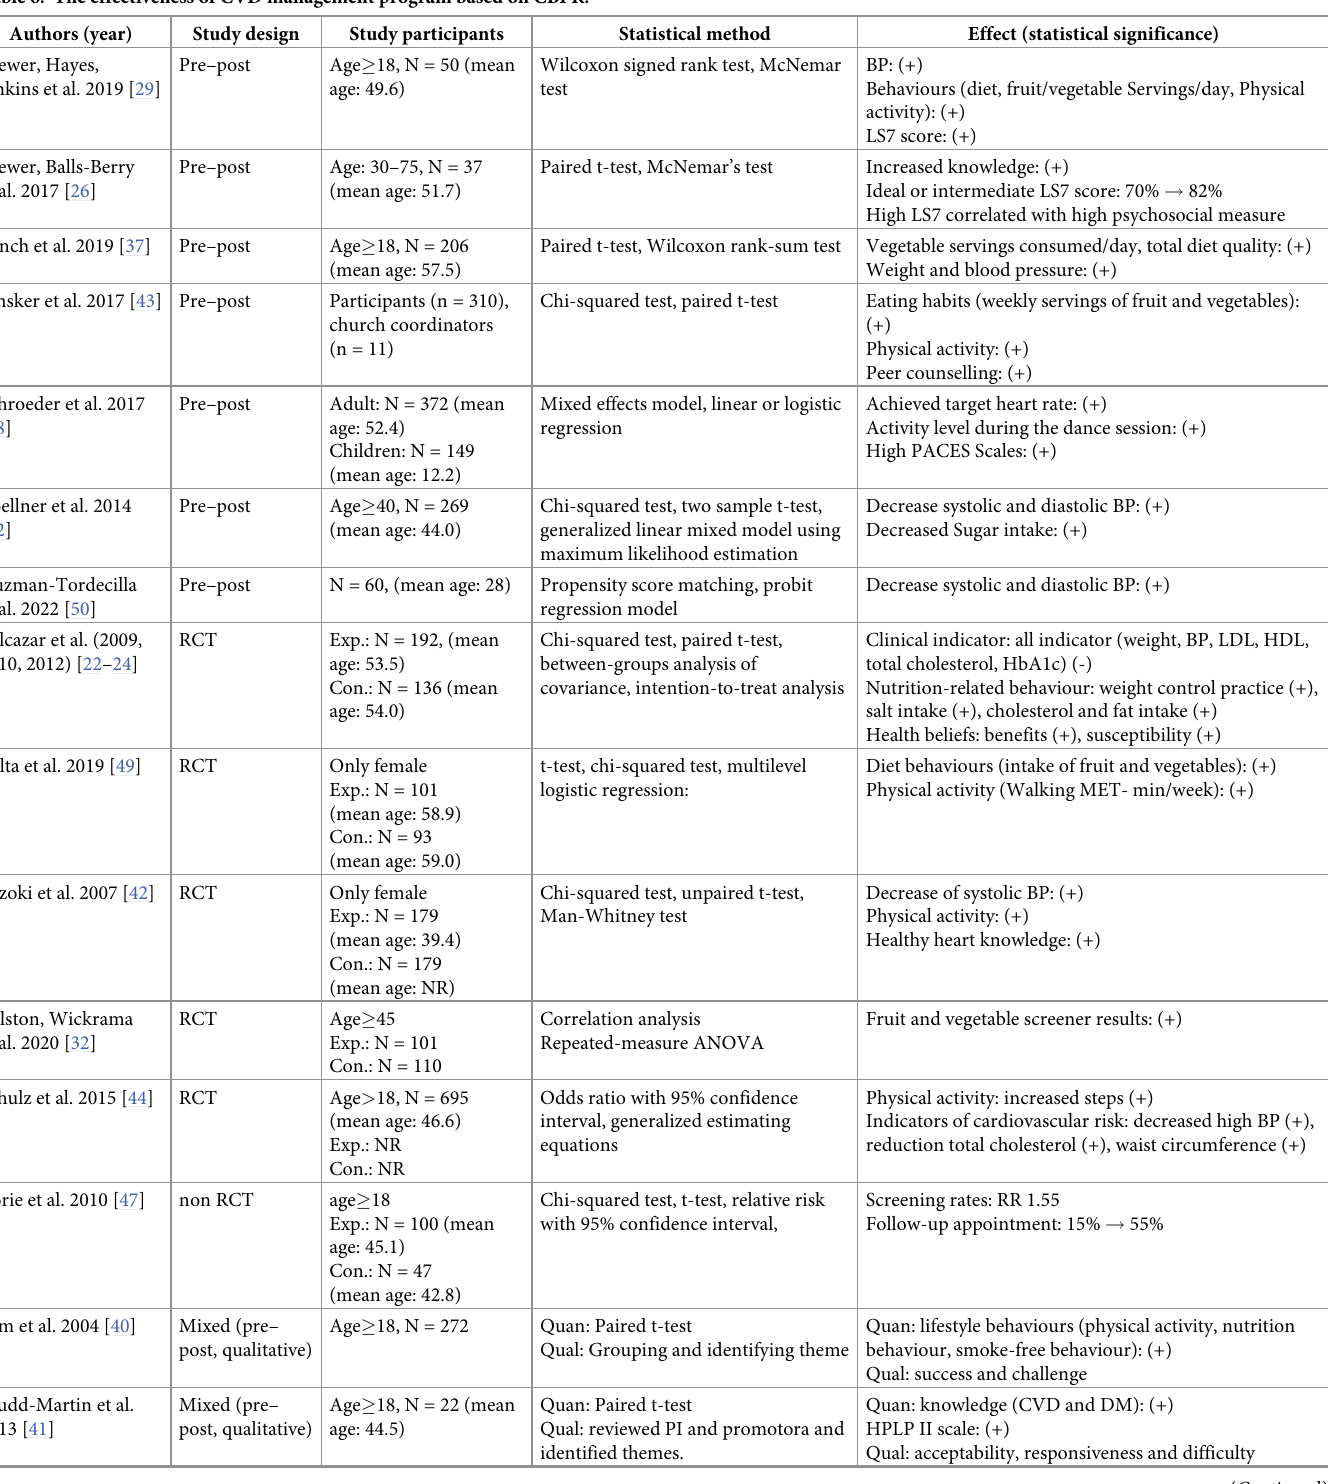
Table 6. The effectiveness of CVD management program based on